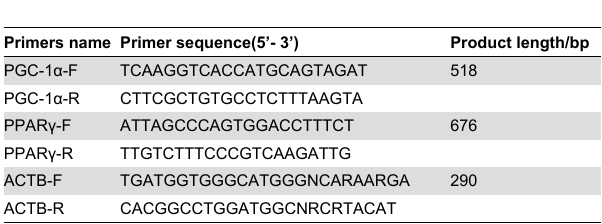
Table 2. Primer sequence used for RT-PCR amplification.